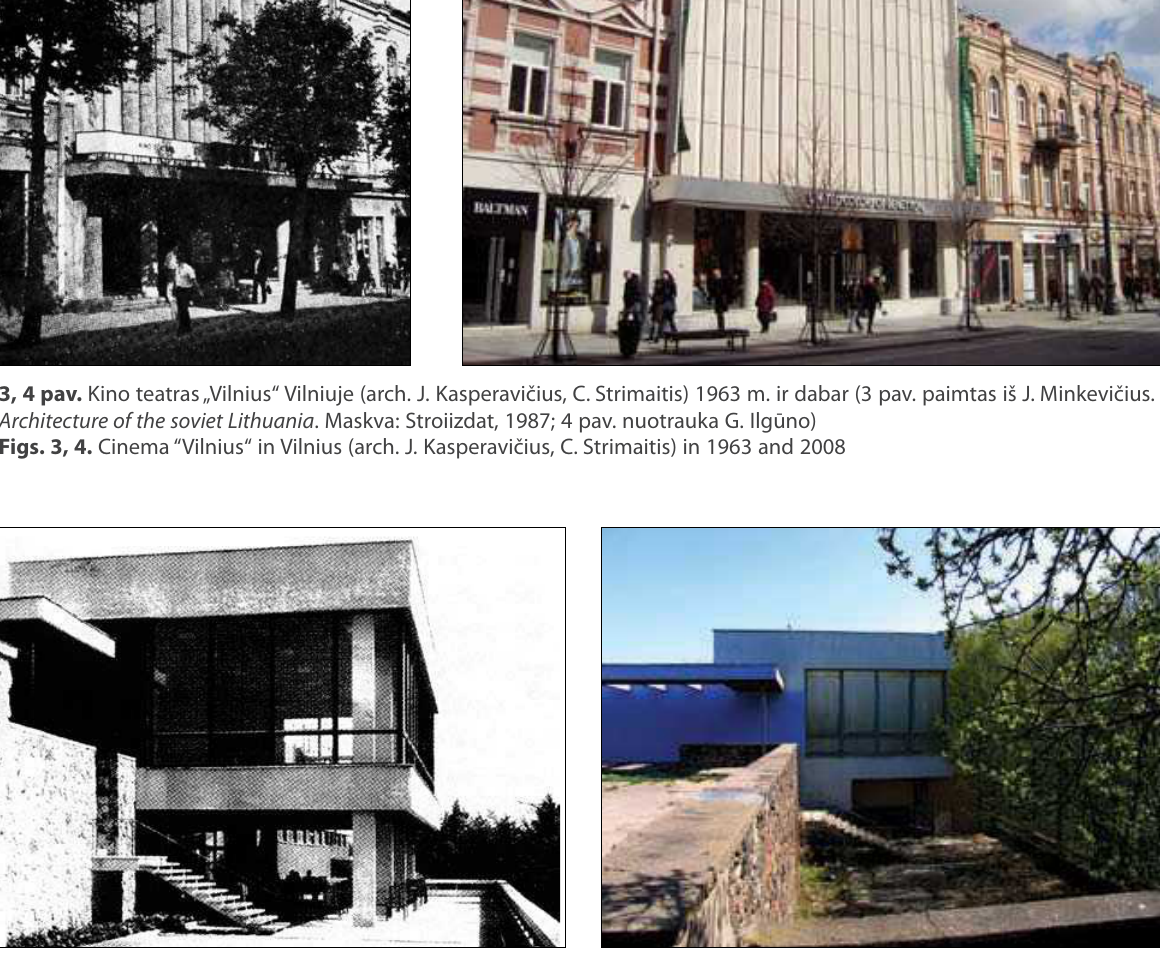
„Trijų mergelių“ kavinė Kaune (5, 6 pav.) laikoma vienu stilingiausių sovietinio laikotarpio architektūros pavyzdžių. Ištęstas pastato siluetas su virš upės kabančiu tūriu, stiprus ir organiškas interjero ryšys su gamta yra gelės“ rekonstruojamos, keičiamas interjeras. Visus lan­ gus aklinai uždengė gipso konstrukcijos.